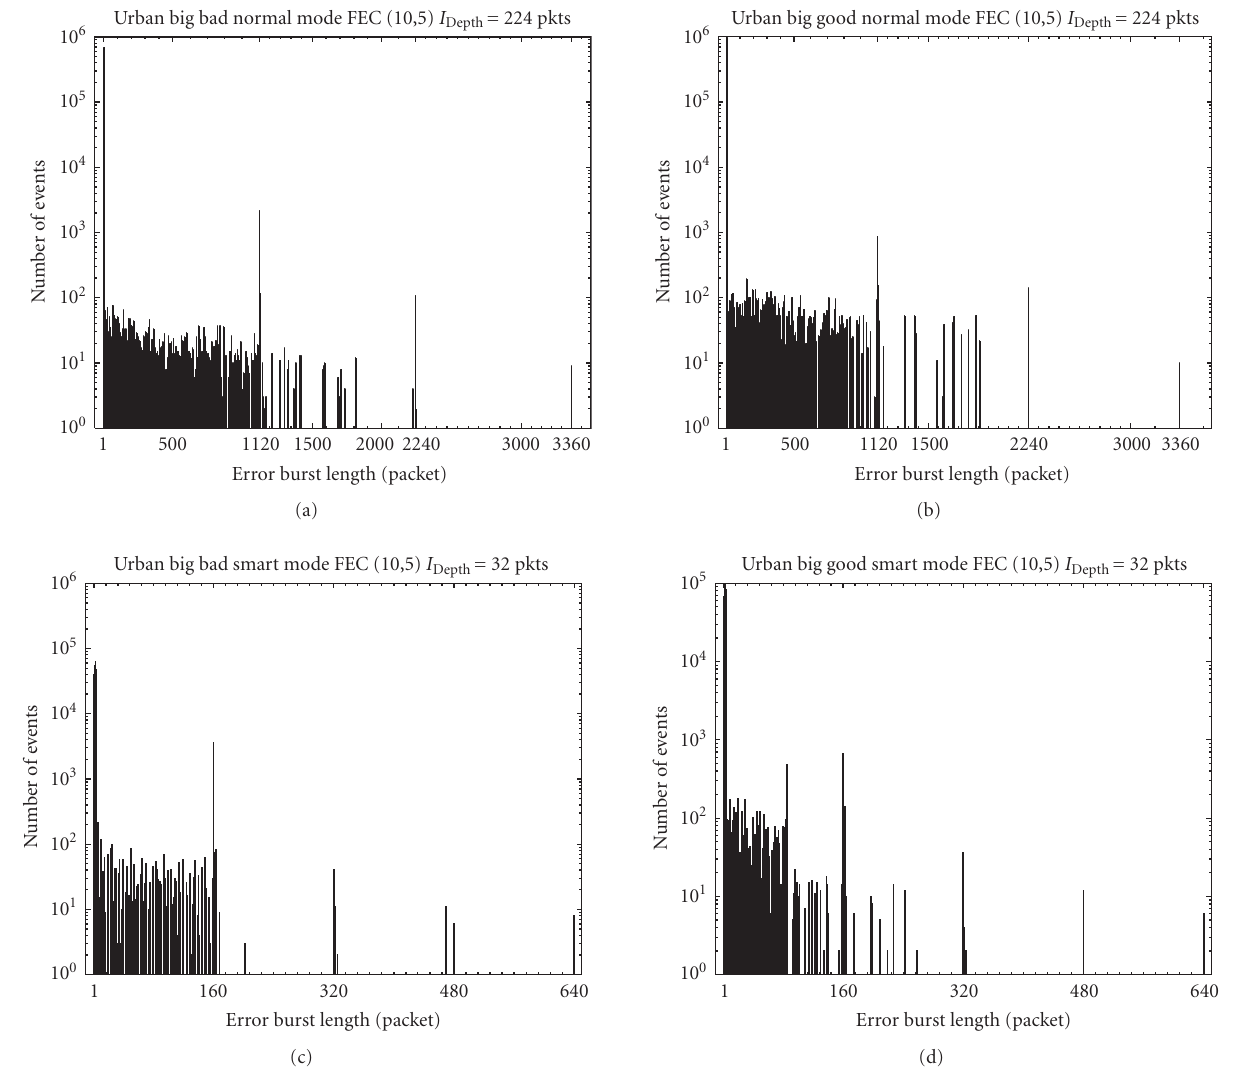
Figure 13: Error burst length distributions with FEC (10,5) in BB and BG and operating in smart mode and normal mode,